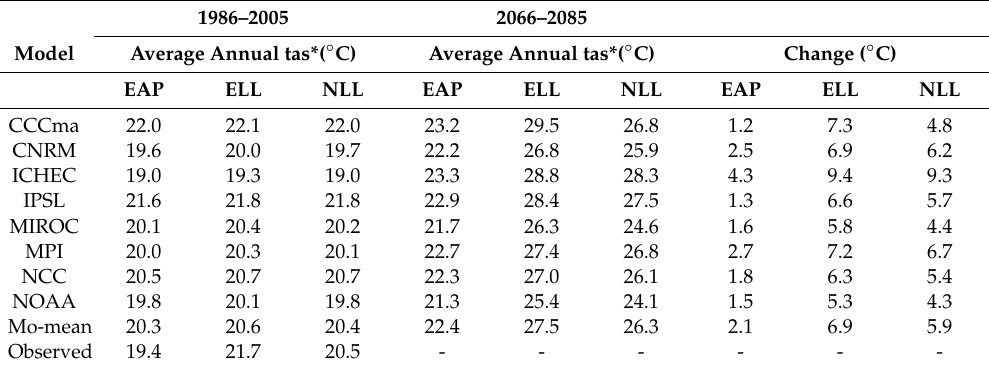
Table 5. Changes in annual temperature